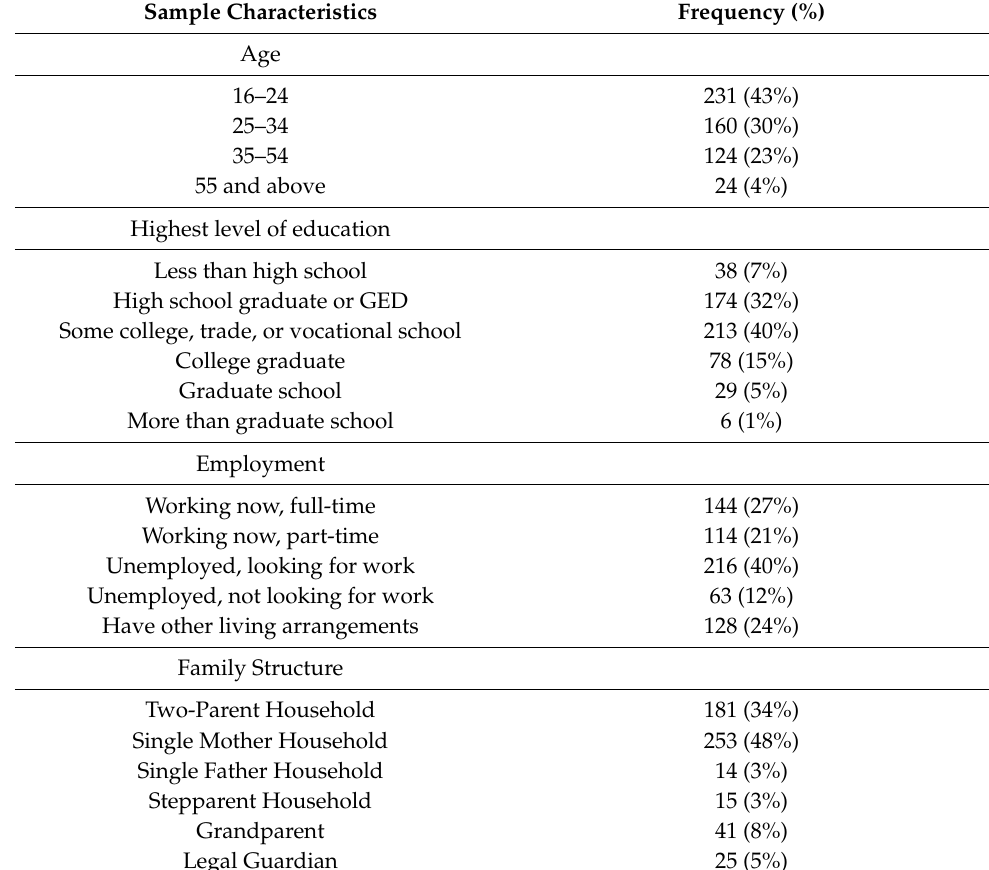
Table 1. Sample characteristics of Black SMM in the Southeastern United States (N = 507).